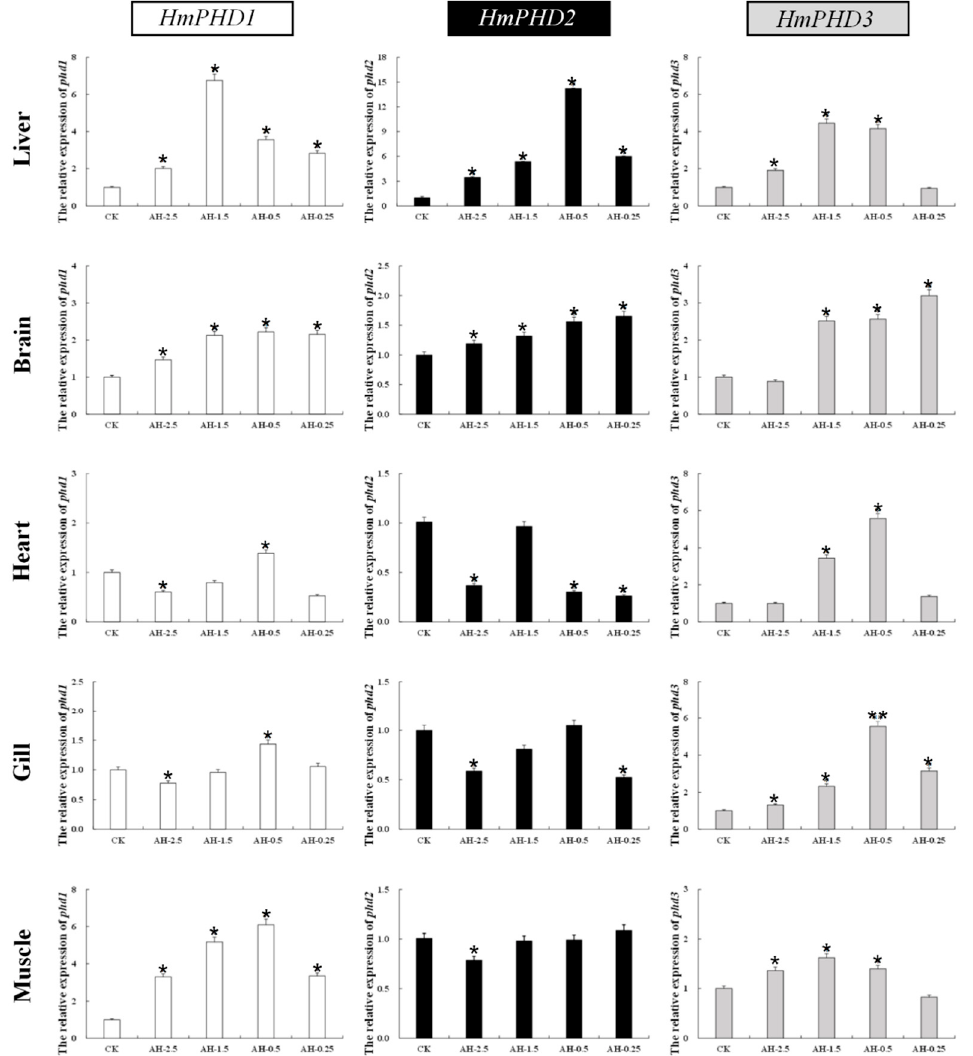
Figure 4. Relative expression levels of PHD genes in the liver, brain, heart, gill, and muscle after normoxia (CK), 0.5 h of hypoxia at 2.5 mg/L (AH-2.5), 1.5 mg/L (AH-1.5), 0.5 mg/L (AH-0.5), and 0.25 mg/L (AH-0.25), respectively. RT-qPCR data presented as mean ± SE. Significant differences at p < 0.05 are labeled with “ * ”, and p < 0.01 are labeled with “ ** ”. AH: acute hypoxia.